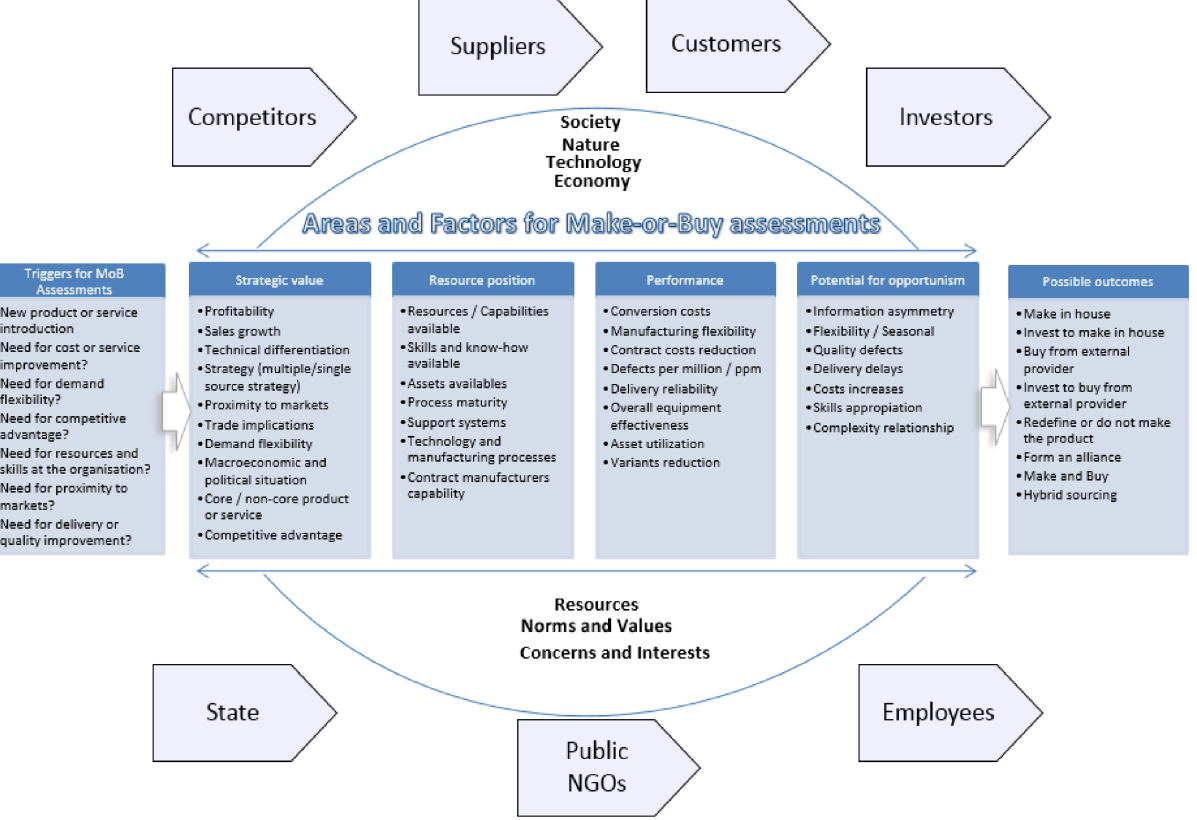
Figure 1. Make-or-buy framework, case